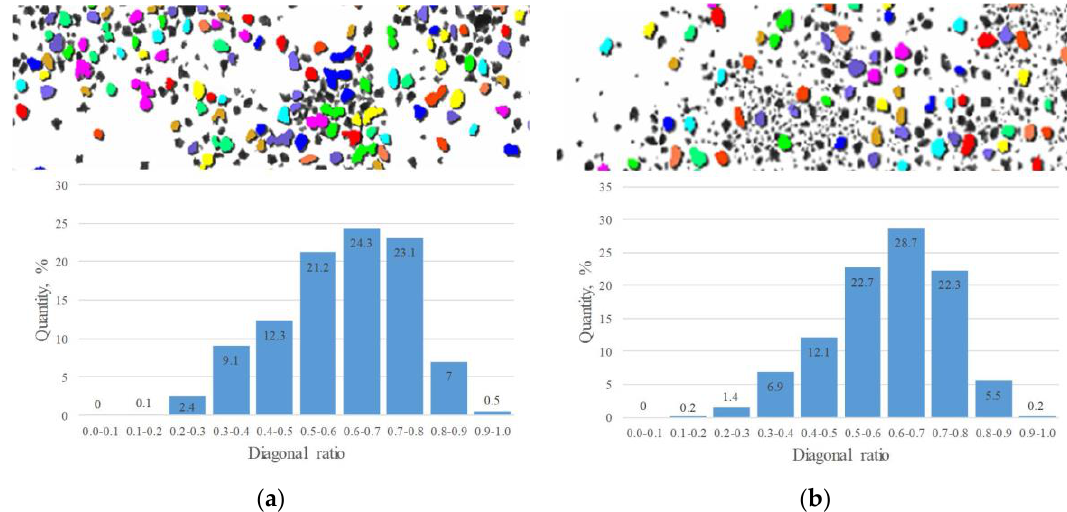
Figure 11. Analysis of example of pellets sample: ( a ) distribution of pellets of first sample according to roundness; ( b ) distribution of pellets of second sample according to roundness.